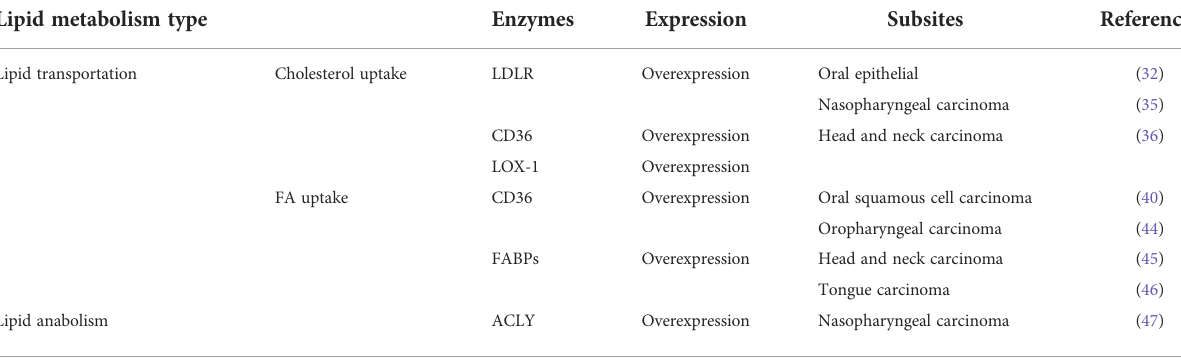
TABLE 1 Expression of key lipid metabolism enzymes in